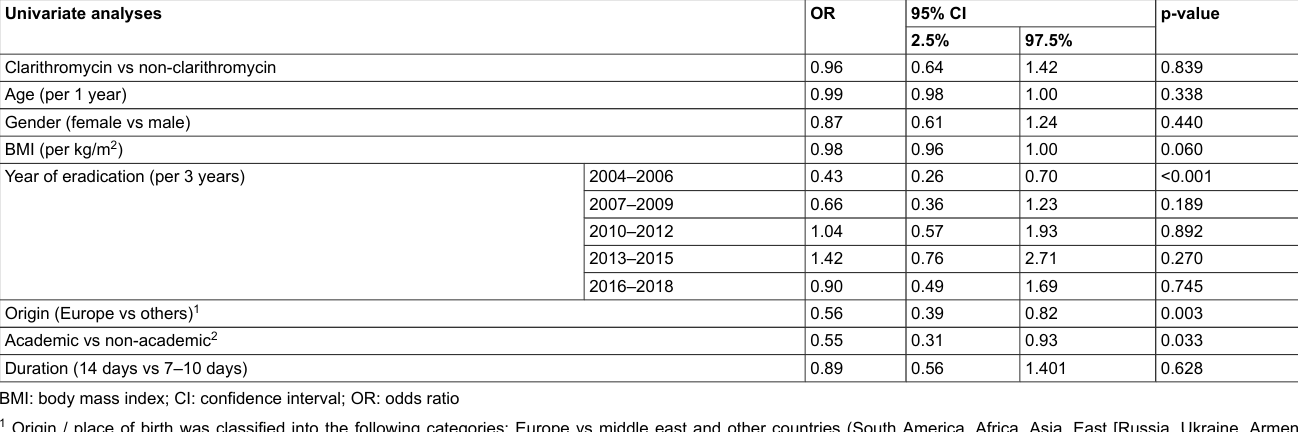
Table 2: Univariate analyses of clinical factors related to Helicobacter pylori eradication success (smaller OR meaning less H. pylori after eradication therapy i.e., better eradication suc- cess). Univariate